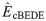
Correlation dependent balanced estimation of diffusion entropies for all the segments.(a)-(g) the segments from seg01 to seg69. Except few segments such as the segment numbered seg08 (red open circles in (a)), all the curves show almost a perfect linear relation of E^cBEDE versus lns in a wide range of scale. For some segments the scale range can reach 13 of the length. The values of slope are all calculated in the scale range of [e0, e4.1], covering about 110 of the length. As for the segment numbered seg08, the scale range is selected to be [e0, e3.3], covering about 120 of the length. The curves are vertically shifted for visual convenience.